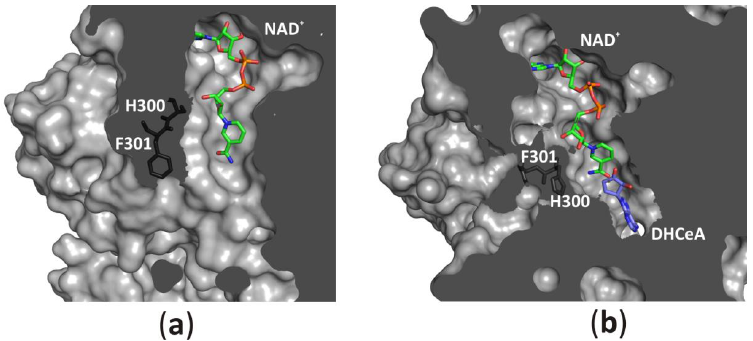
Figure 8. Accessibility of the active site from the solvent region is regulated by a “molecular gate” formed by a conserved His-Phe diad; ( a ) For the rat enzyme in its substrate-free state the channel is open, whereas ( b ) for the human enzyme in a complex with the adenosine analog (2′-hydroxy- 3′- ketocyclopent-4′-enyladenine, DHCeA), the channel is closed with no access to the substrate-binding site. Amino acid residue numbers correspond to those of human and rat SAHase.